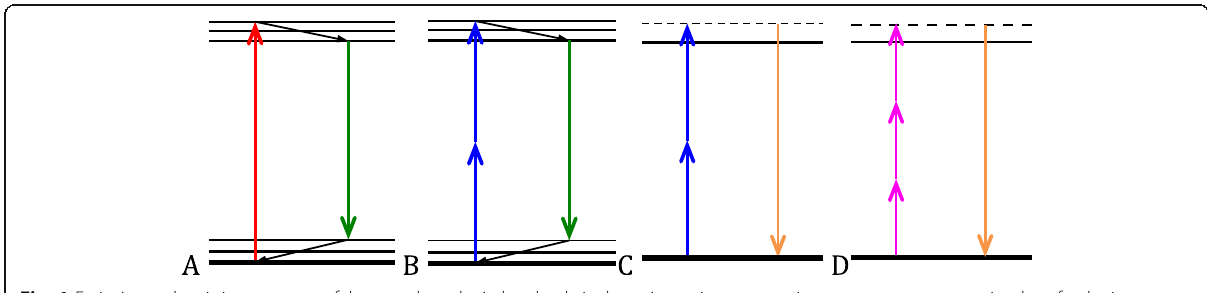
Fig. 1 Excitation and emission processes of the same hypothetical molecule in the various microscopy regimes represents: a conventional confocal microscopy: where a single photon of wavelength equal to λ 0 excited molecule and produces a wavelength emission equal to λ 1 , where λ 1 > λ 0 ; b two-photons excited fluorescence: where two photons with wavelength equal to second harmonic generation microscopy: where two photons with wavelength equal to . λ λ 2; and d third-harmonic generation microscopy: where three photons with wavelength equal to 0 3 = . λ equal to λ 4 , where λ 4 = . The color arrows have length proportional to the energy of the photons and black arrows indicate vibrational energy loss. Solid 0 3 lines represent real energy levels and dashed lines represent virtual energy levels